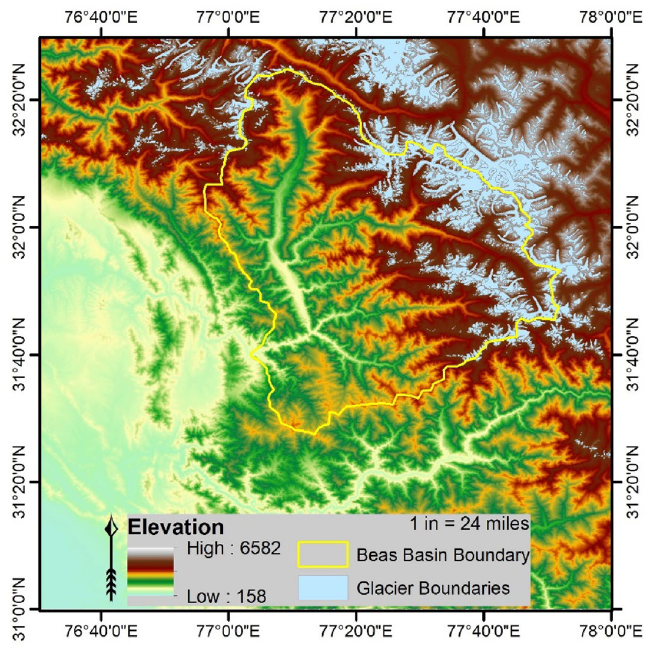
Figure 1. Beas basin with basin boundary, underlaid by Digital Elevation Model (SRTM 90 m). The highest and lowest elevation within the basin boundary is approximately 6545 masl and 826 masl, respectively. The sky